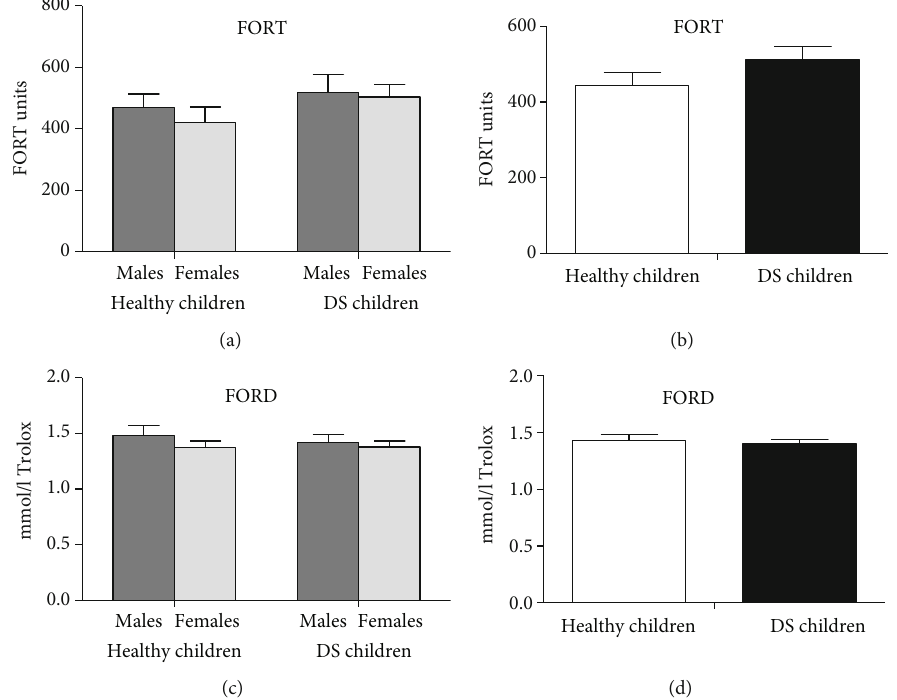
Figure 3: Free oxygen radicals test (FORT) and free oxygen radicals defense (FORD) levels in male and female DS prepubertal children and in the control group (the left panels represent the full interaction and the right panels are without the gender e ff ect). The error bars indicate pooled standard error means (SEM) derived from appropriate error mean square in the